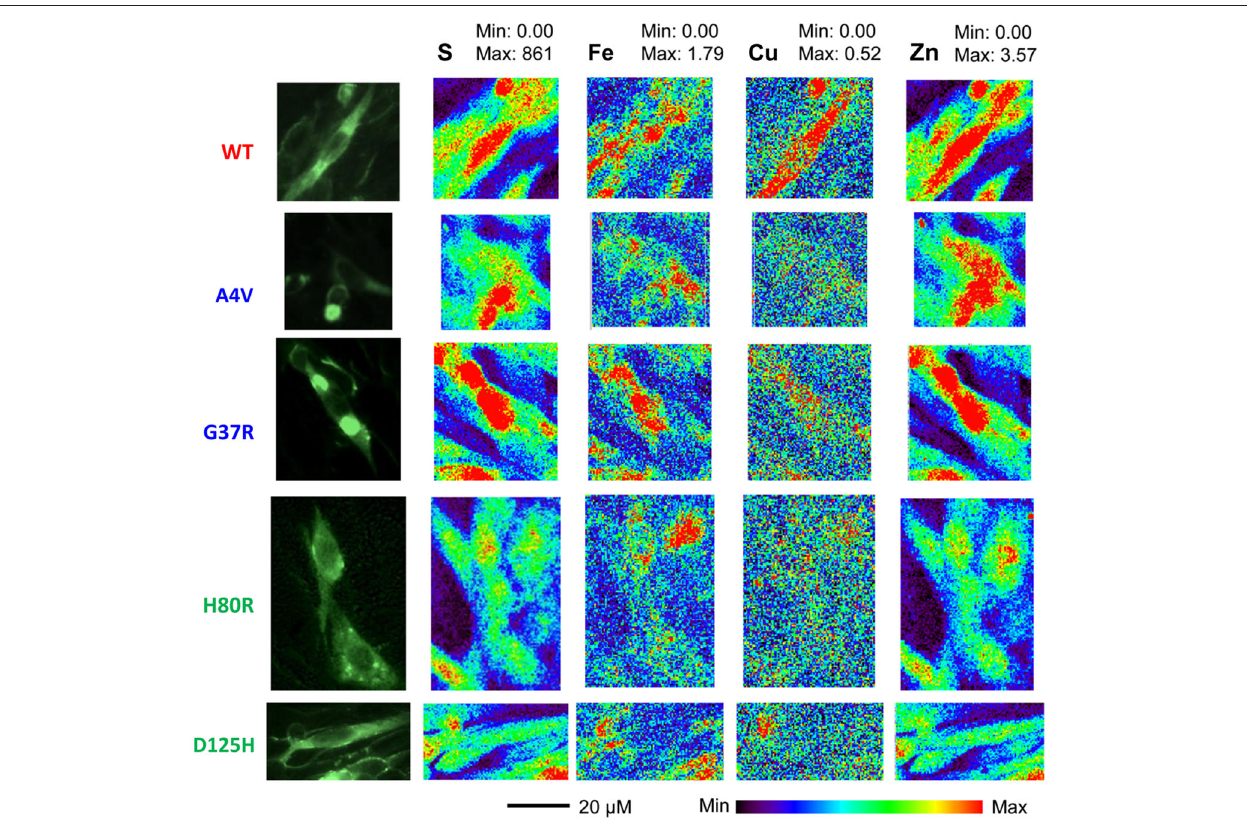
(fifth column). The XFM images show the relatively large amounts of copper and zinc found in the WT cells compared to the mutant SOD1 cells. Minimum and maximum concentrations are in